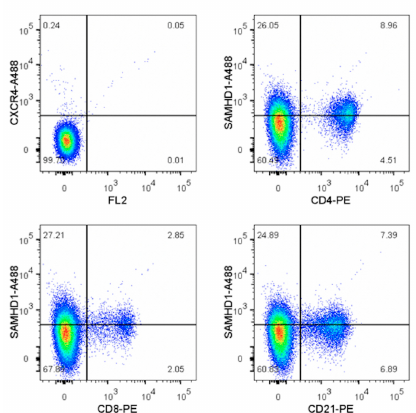
Figure 5. Detection of SAMHD1 relative to lymphocyte antigens on primary feline PBMC. Representative plots show staining for SAMHD1, CD4, CD8, and CD21. A proportion of both T and B lymphocytes are positive for SAMHD1. Once purified, CD4 + lymphocytes were maintained with IL2, and after 48 h of culture, they were uniformly positive for SAMHD1 (Figure 6A). Treatment with IFN γ did not significantly increase detection of either SAMHD1 or pSAMDh1 in the whole cells or nuclei.